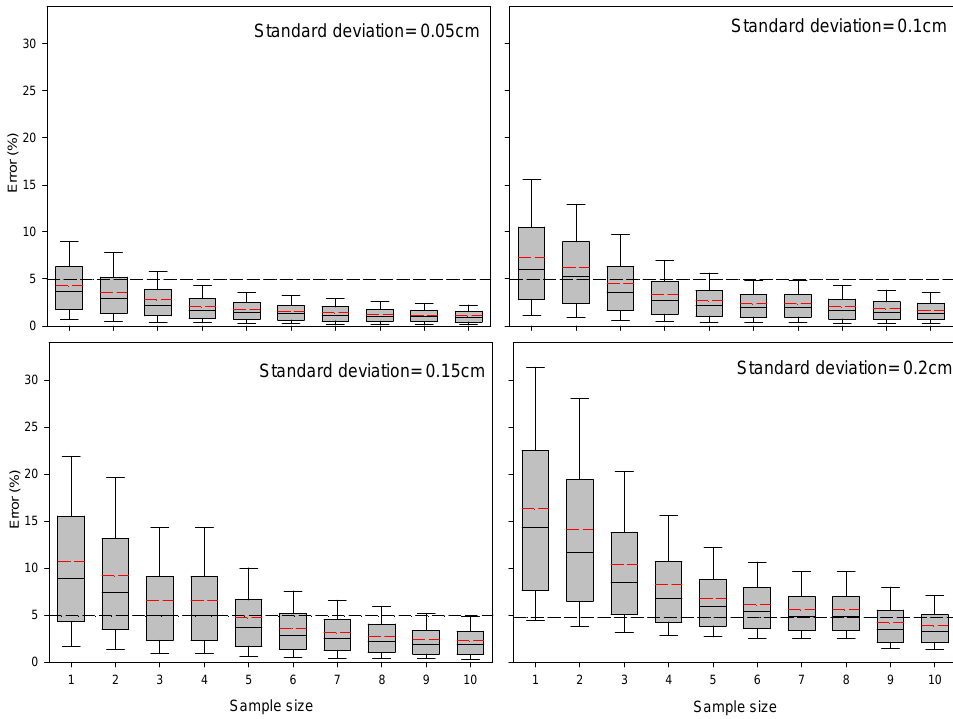
Fig. 8. Variability in error estimates among the 5000 simulations involving various sample sizes and 4 levels of standard deviation. The solid lines indicate the average, the dashed lines indicate the mean, the boxes indicate the 25th and 75th percentiles, and the bars indicate the 10th and 90th